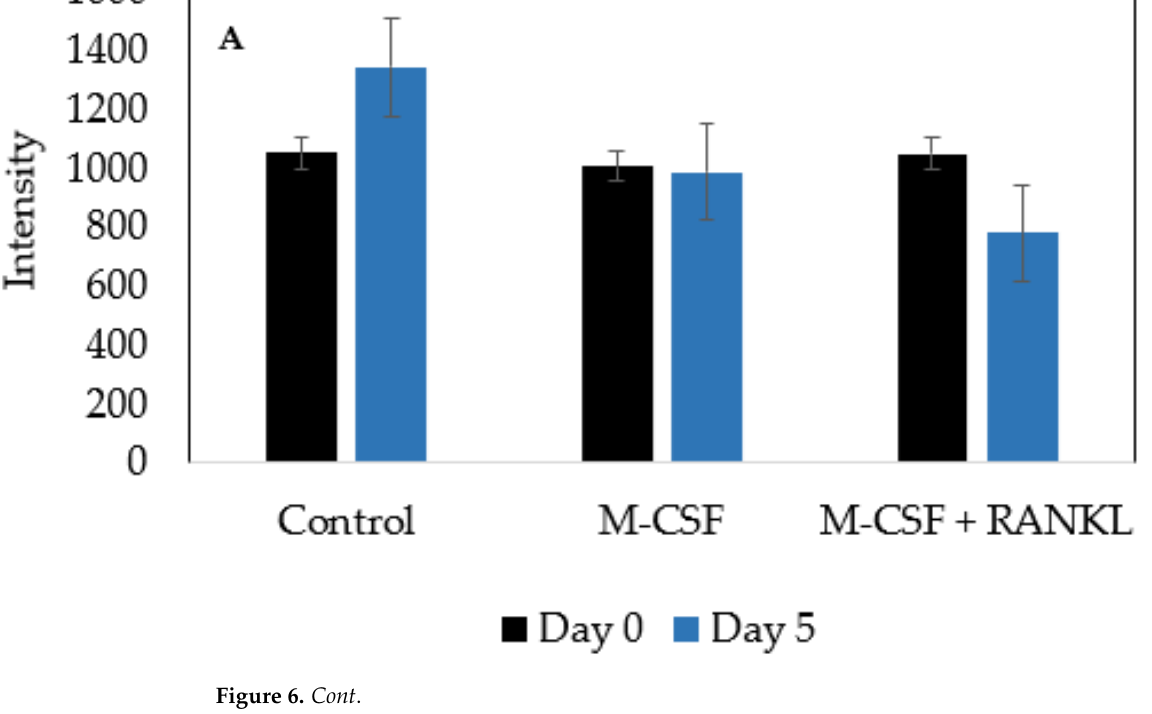
Figure 6. Calcein-AM-red-orange and Green Live/Dead staining for proliferation and viability. ( A ) Graphical representation of Calcein-AM fluorescence in different conditions. ( B ) Visual representa- tions of Calcein-AM and Live/Dead stains. Cells were counted for 5 days, and immunofluorescence was captured using an epifluorescent microscope. Calcein-AM is indicative of the total number of viable cells, whereas green indicates an unviable cell. Scale bars are set to 10 μ m. All experiments were conducted in triplicate and images were processed using ImageJ. 3.5. Osteoclasts Isolated from OA Patients Express TRAP and Cathepsin K Osteoclasts express active enzymes that are responsible for degrading old or dam- aged bone. The most notable osteoclast markers are TRAP and Cathepsin K, as both as are